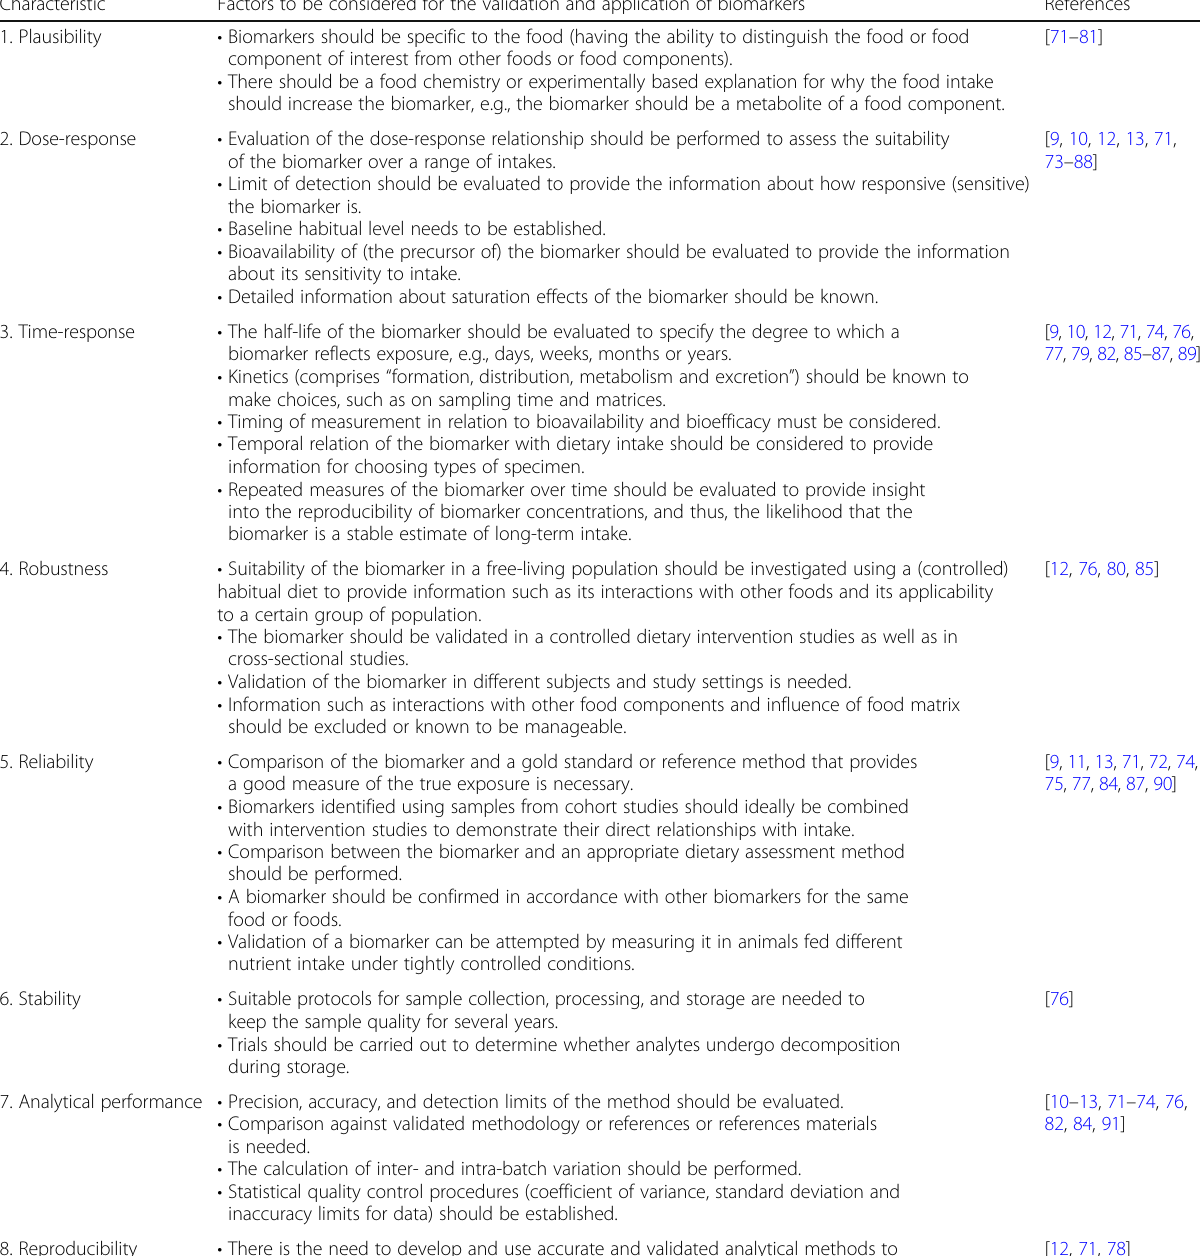
Table 1 Factors to be considered for the validation and application of biomarkers suggested in previous literature